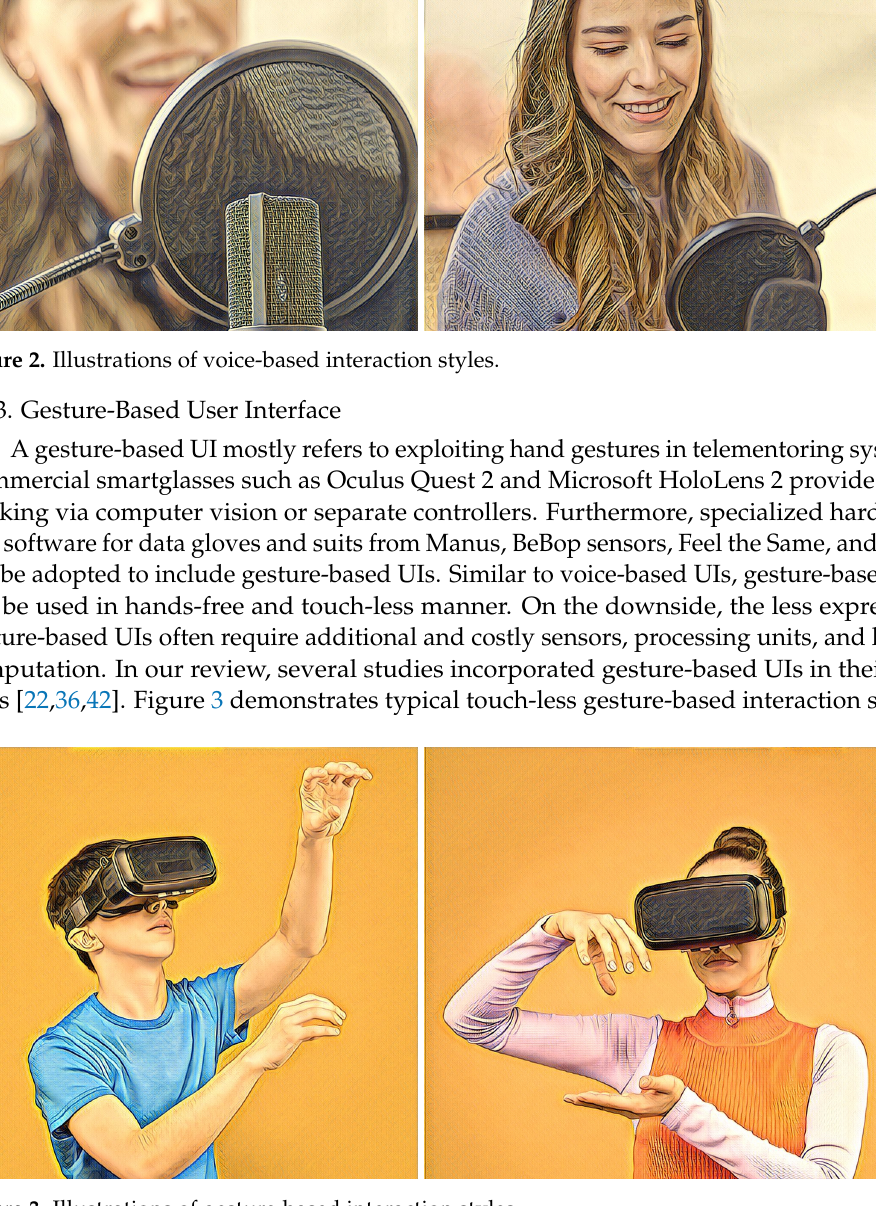
Figure 3. Illustrations of gesture-based interaction